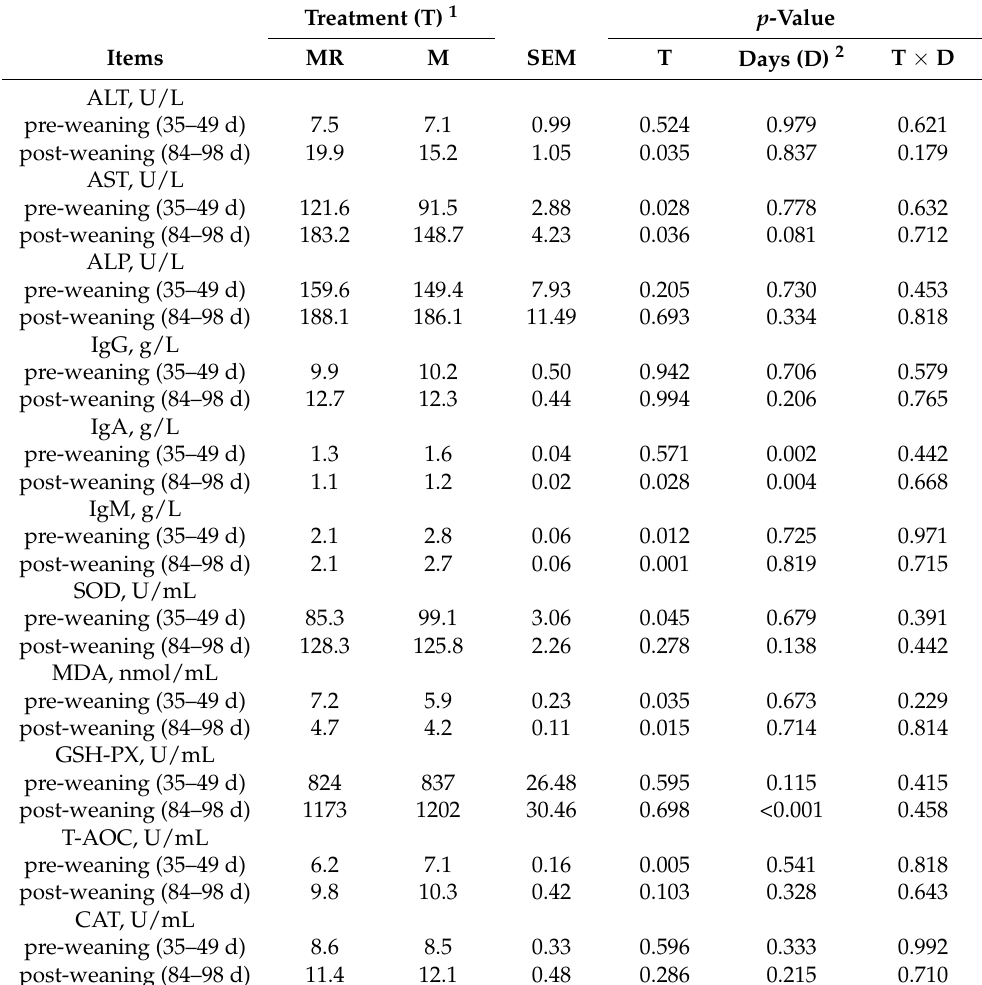
Table 3. Serum variables as influenced by feeding milk versus milk replacer to calves. ( N = 6 per